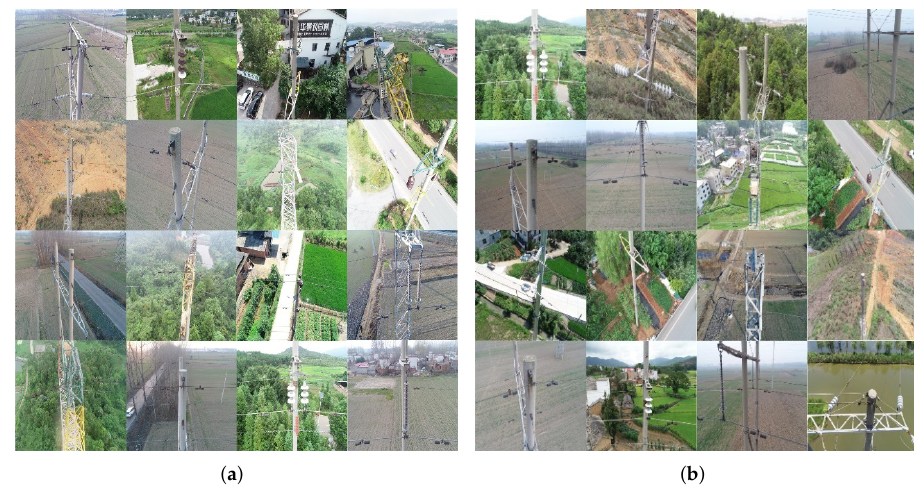
Figure 10. Examples of UAV images used in this experiment. For better illustrative effect, we divide the examples into the two groups, as shown in the subfigures ( a , b ).